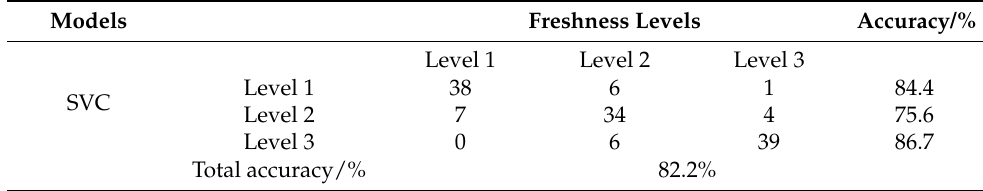
Table 6. External validation for freshness levels in mini-Chinese cabbage by SVC.